Question: In a single sentence, describe what this figure presents.
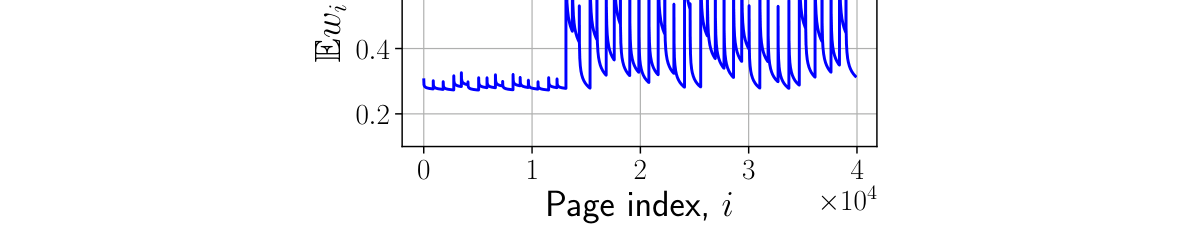
Answer: Expected average page weights wi show that queries to the first pages assigned to scanned tables are less costly than others. Since we take into account not only the frequency of the requested pages but also the corresponding cost (cscan or cget), the expected average weights accumulate this information, as well.